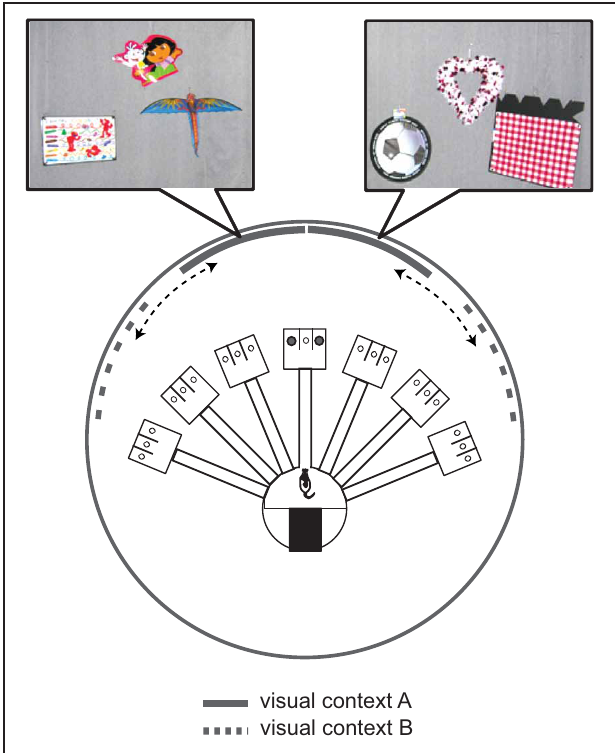
FIGURE 3 | A contextual response-selection task. Visual context is defined by the configuration (parameterized by the angular distance) of the two curtains (each with a distinct set of visual cues as shown in the pictures). For example, context A is defined by the two cue-curtains aligned at the center (thick arc lines) and context B is when the two cue-curtains set apart by a larger degree (dotted arc lines).